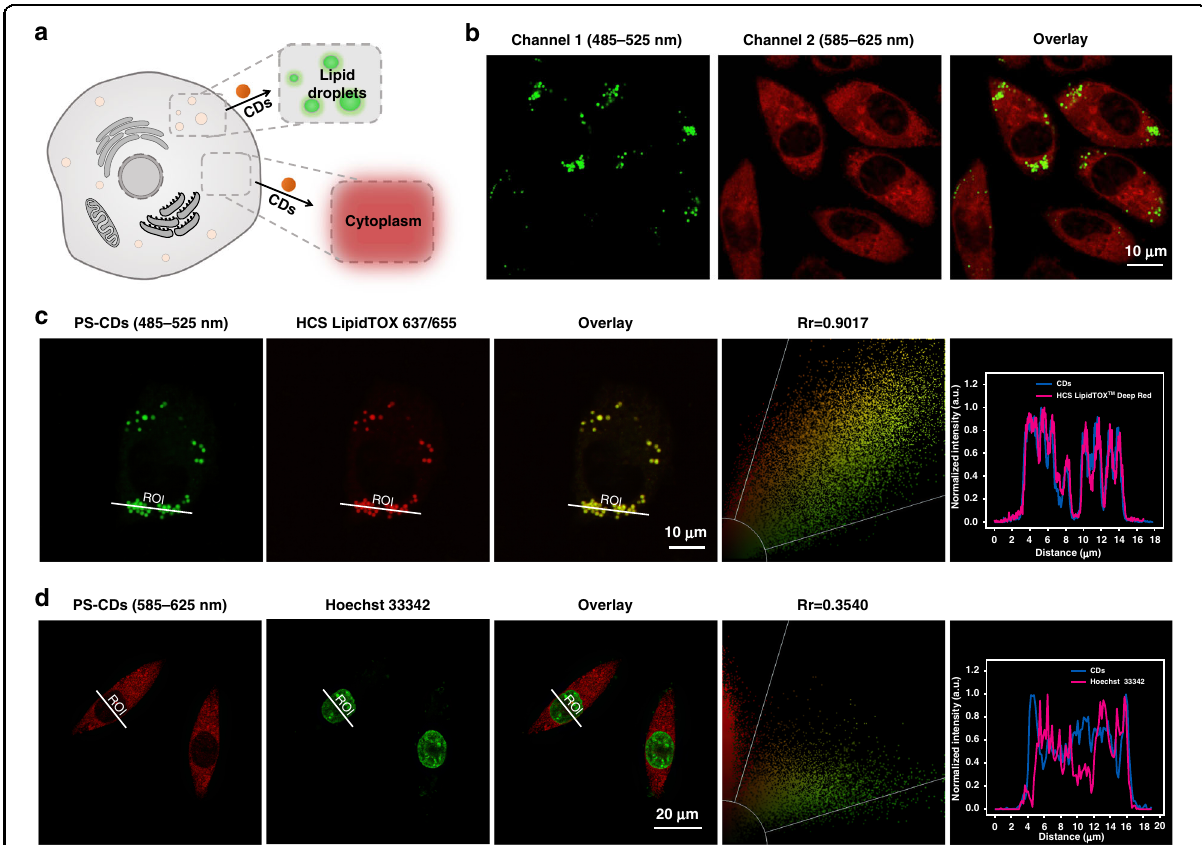
Fig. 3 Subcellular colocalization assays of PS-CDs with commercial organelle dyes. a Schematic diagram of LDs and cytoplasm imaging by PS- CDs with two fl uorescent colors. b Confocal microscope images of SMMC 7721 pretreated with PS-CDs (50 μ g mL − 1 ), λ ex = 476 nm. c Confocal microscope images of HepG 2 cells pretreated with PS-CDs (50 μ g mL − 1 ) and HCS LipidTOXTM Deep Red (1:1000 dilution), λ ex (PS-CDs) = 476 nm, = 637 nm. d Confocal microscope images of SMMC 7721 cells pretreated with PS-CDs (50 μ g mL − 1 ) and Hoechst 33342 (1 μ L), λ λ ex (HCS) 476 nm, λ ex (HCS) = 405 nm. Scale bar, 10 μ m in a , b ; Scale bar, 20 μ m in